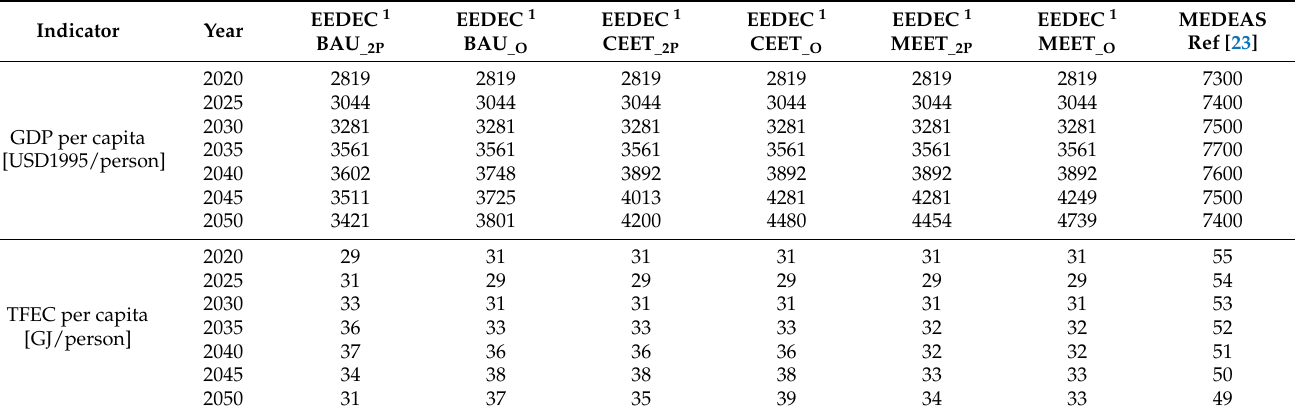
Table 3. Comparison of GDP per capita and Total Final Energy Consumption per capita for EEDEC and MEDEAS.